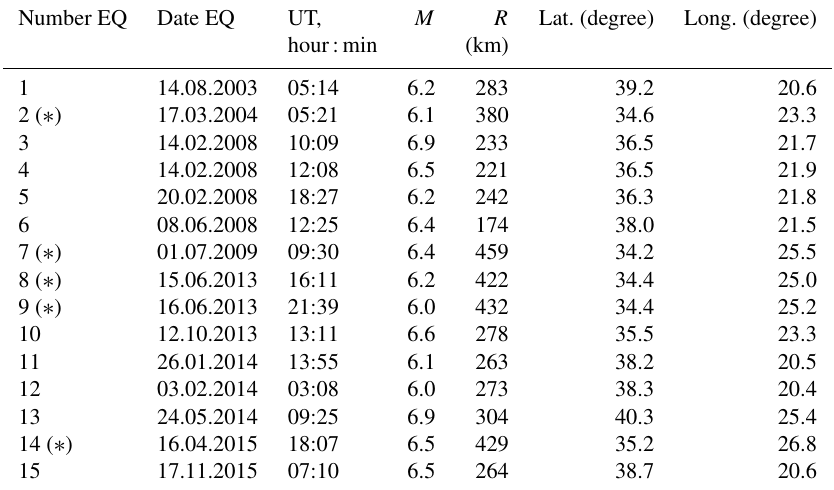
Table 1. List of the shallow earthquakes (hypocentral depth < 50km) with magnitude M ≥ 6 . 0 registered in Greece during 2003–2015. Geographical coordinates of the earthquake epicentres (from United States Geological Survey USGS, 2017) and the distance ( R ) from the Athens ionosonde are also given. EQs with ( ∗ ) have not been analysed because are too distant from the Athens ionosonde station ( R > 350km).